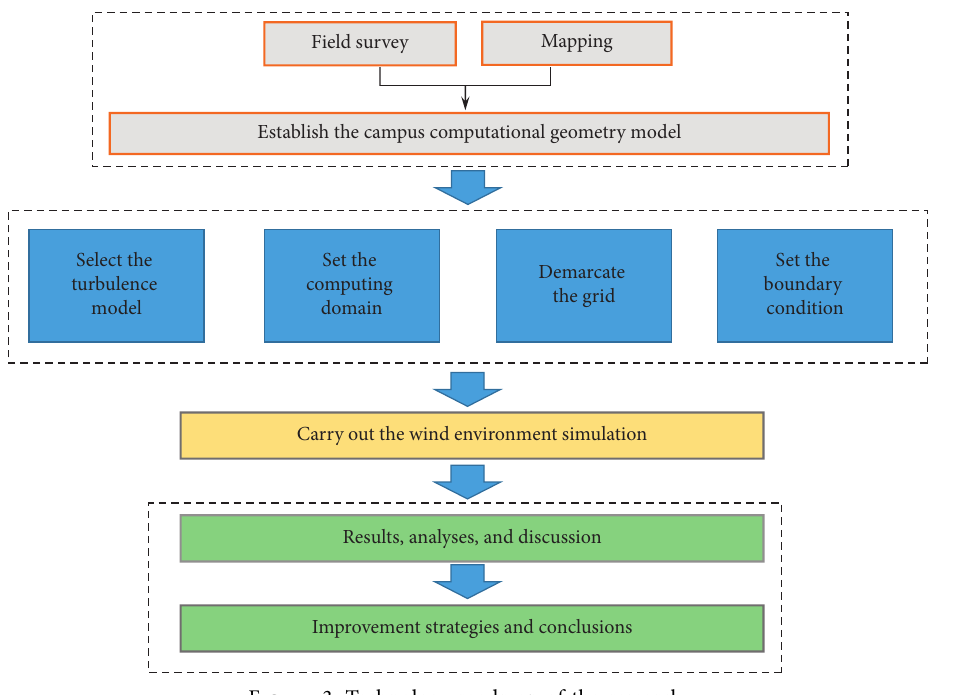
Figure 3: Technology roadmap of the